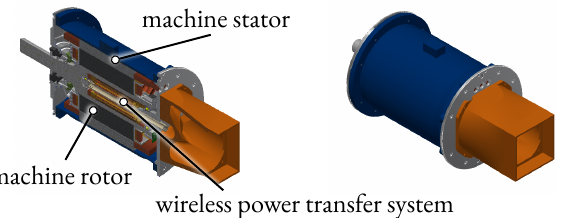
Figure 1. CAD model of the integrated inductive electrically excited synchronous